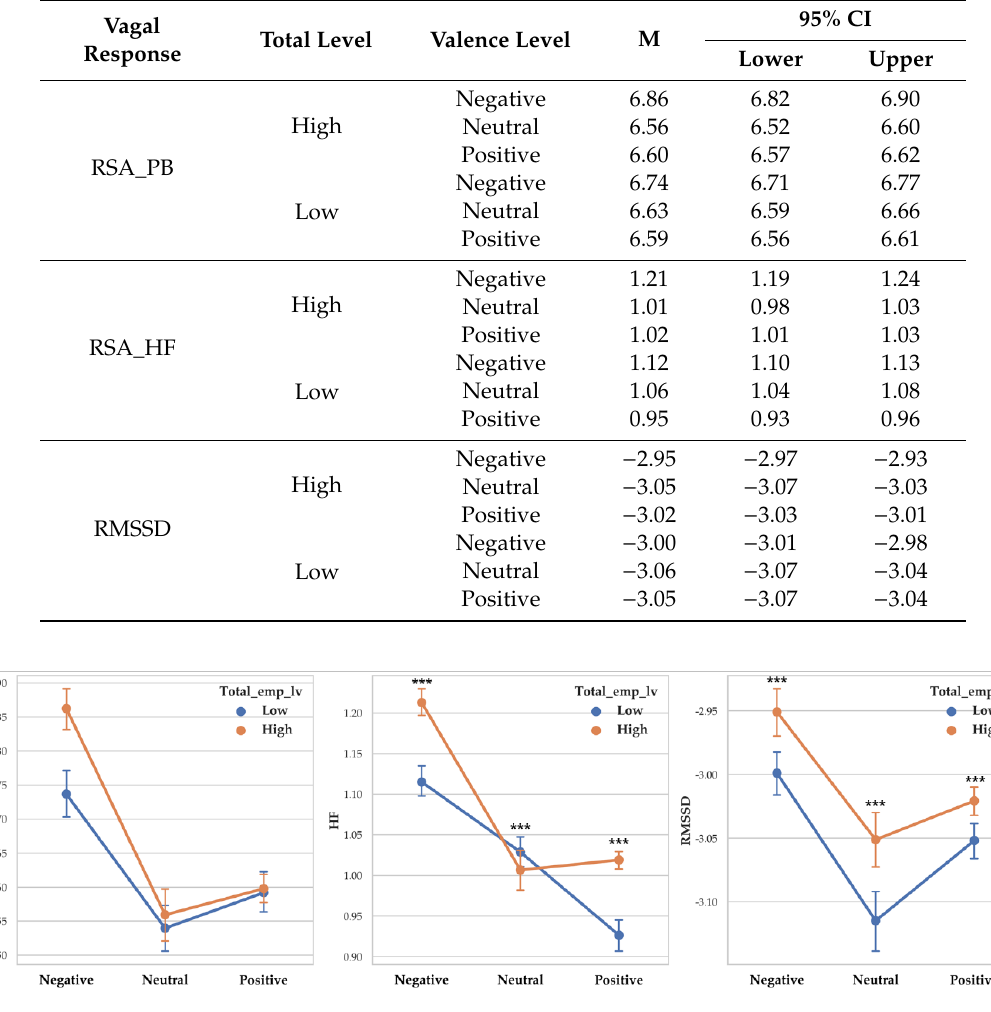
Table 11. Descriptive statistics for vagal response depending on total empathy level and arousal. M = Mean, SD = Standard deviation. 95% CI = 95% of confidence interval.